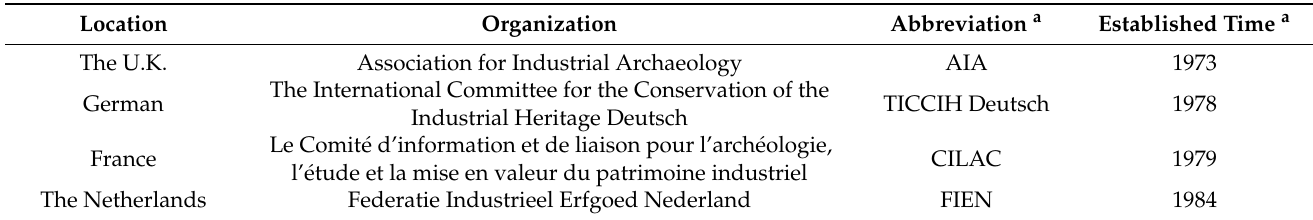
Table 2. Schedule of main industrial heritage inspection and research institutions in Western European countries. Location The U.K.